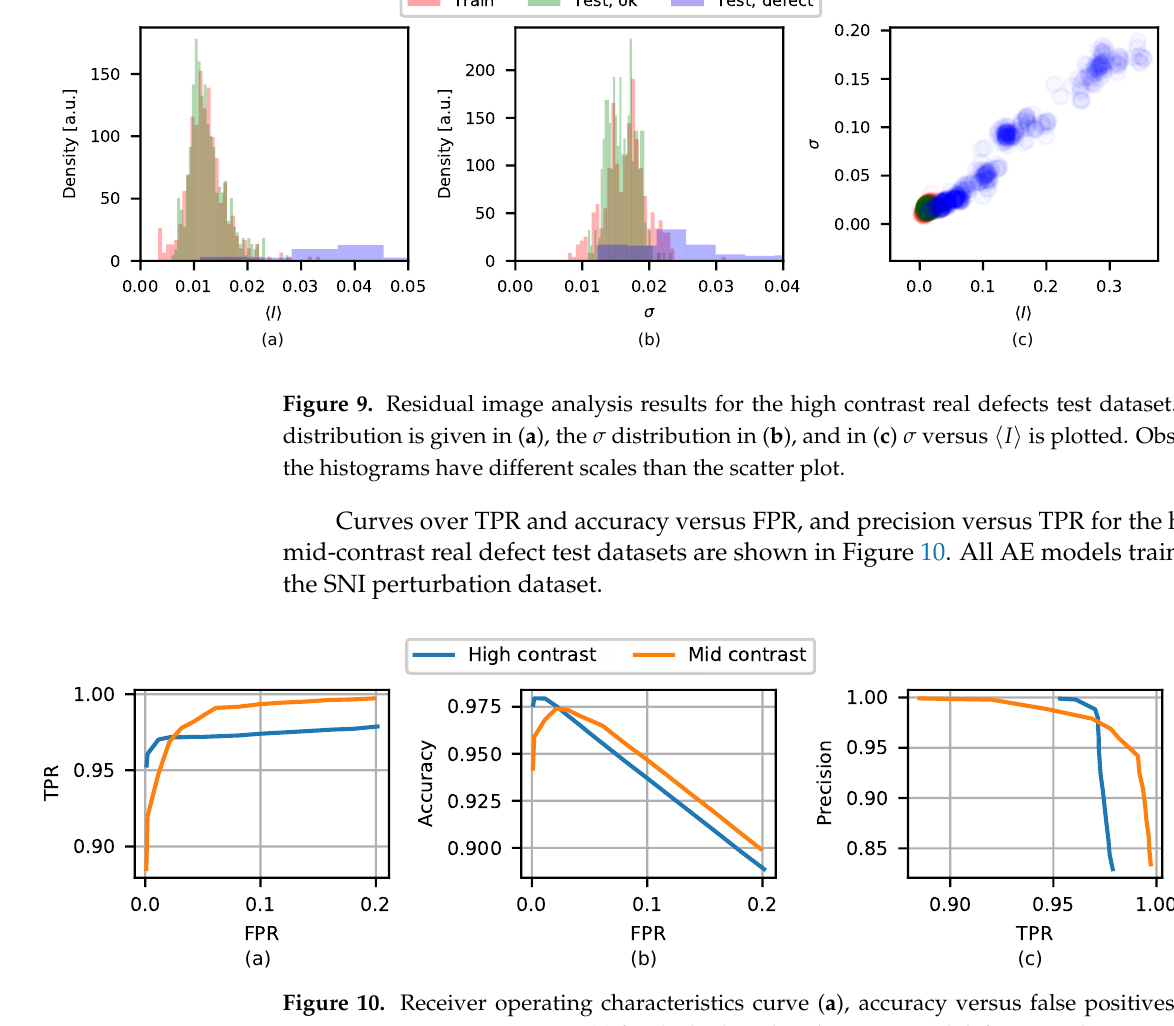
Figure 10. Receiver operating characteristics curve ( a ), accuracy versus false positives ( b ), and precision versus true positives ( c ) for the high and mid-contrast real defects test datasets. All values are in